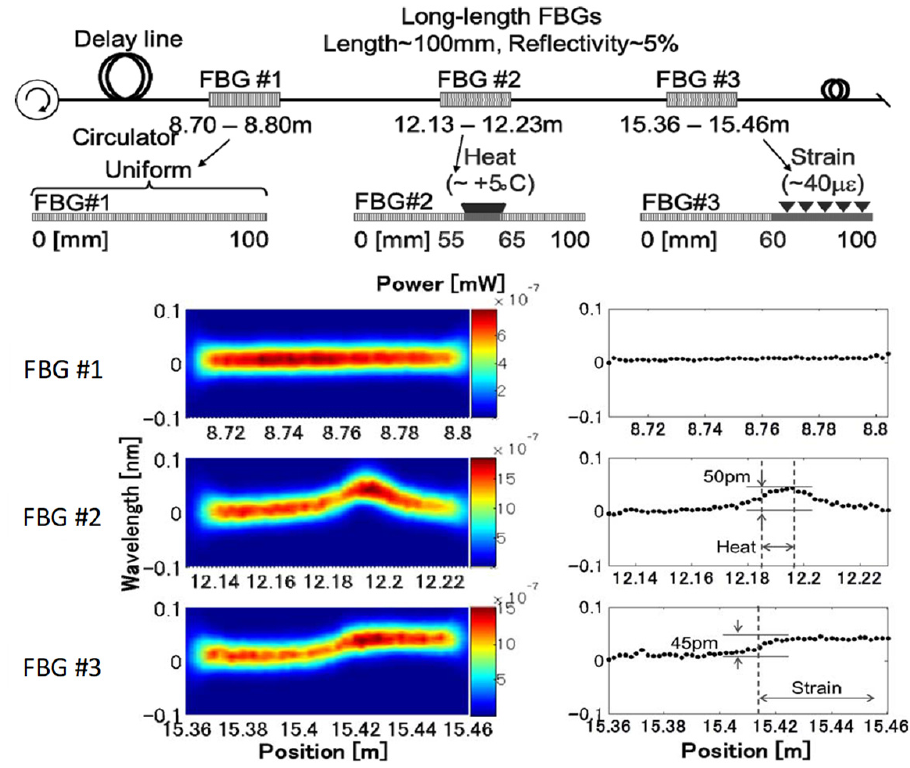
Figure 14. Experimental demonstration of the quasi-distributed sensing in the system that is shown in Figure 13 [31]. Bragg wavelength distribution along long-length FBGs are successfully obtained by the SOCF technology.